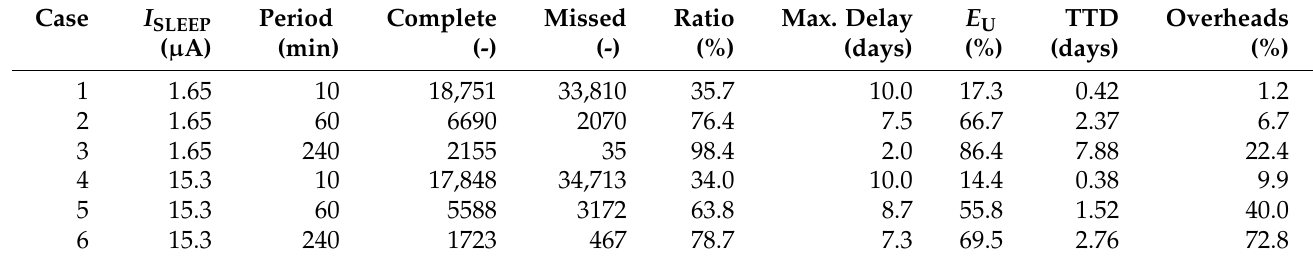
Table 8. Results of the simulated configurations. A missed cycle is a period during which transmission was required but energy was insufficient. The ratio represents the percentage of successful cycles and total periods. E U is unused energy. TTD represents the time to discharge, and overheads represent consumption during